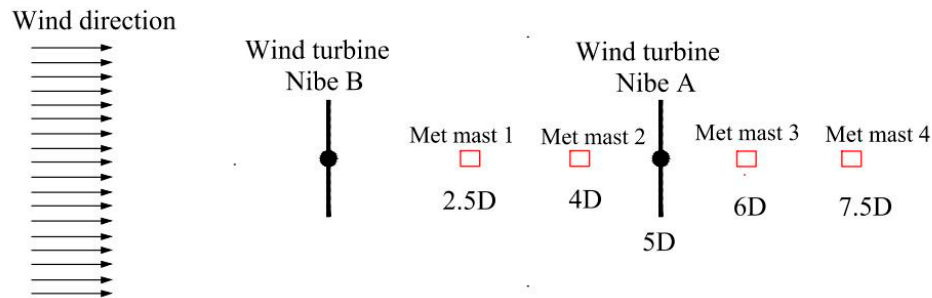
Figure 4. Schematic diagram of the Nibe wind turbines and the wake measurement locations (Top view).